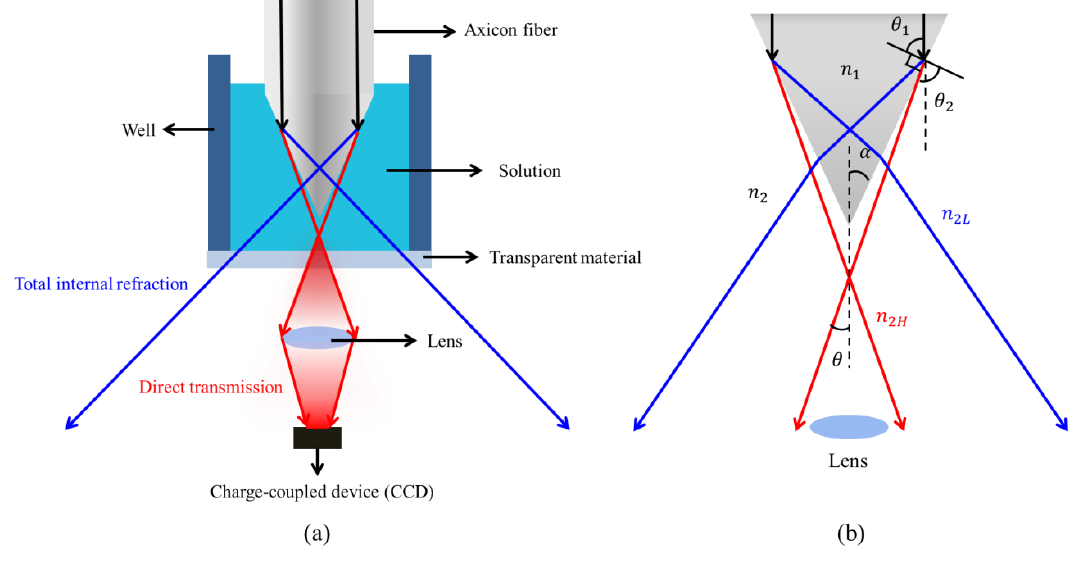
Figure 1. ( a ) A transparent axicon fiber tip combined with a camera device to detect the refractive index in the test solution; ( b ) the relation between the refractive index of the axicon tip and the divergence angle; and the divergence angle versus the refractive index at different angles of the tip.